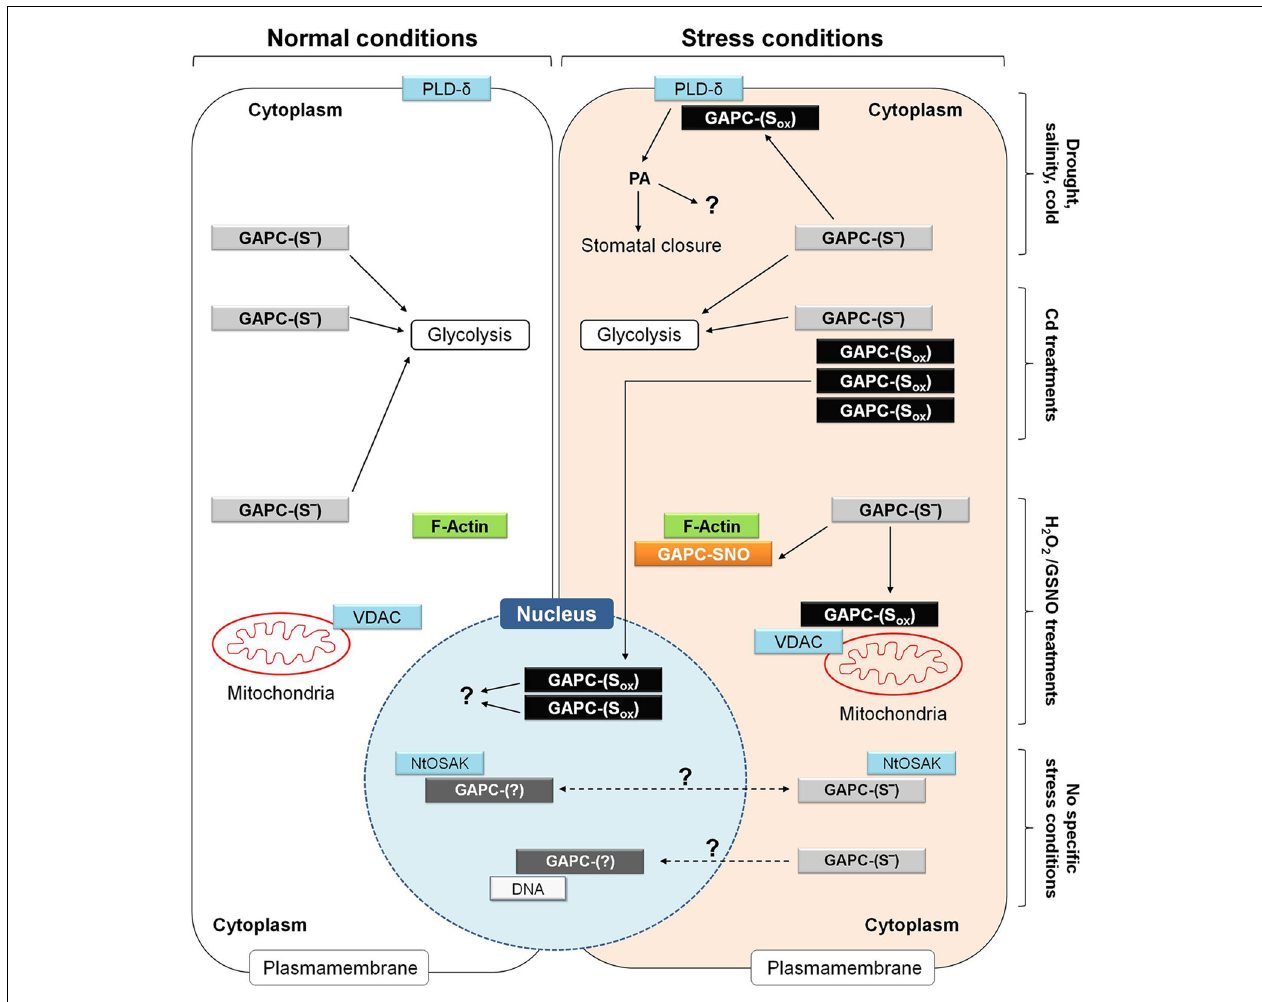
different type of redox modifications of GAPC (GAPC-S ox ) and stimulate interaction with several partner proteins or to induce protein expression, accumulation of inactive protein and relocalization to the nucleus. Additional functions of GAPC are not clearly related to either specific stress conditions or redox modification or sub-cellular localization of the GAPC protein and are indicated by dashed arrows. For a detailed explanation, see text (Plant Glycolytic GAPDH: Metabolic and Non-Metabolic Functions). NtOSAK, Nicotiana tabacum osmotic stress activated kinase; PA, phosphatidic acid; PLD- δ , phospholipase D- δ ;VDAC, voltage-dependent anion